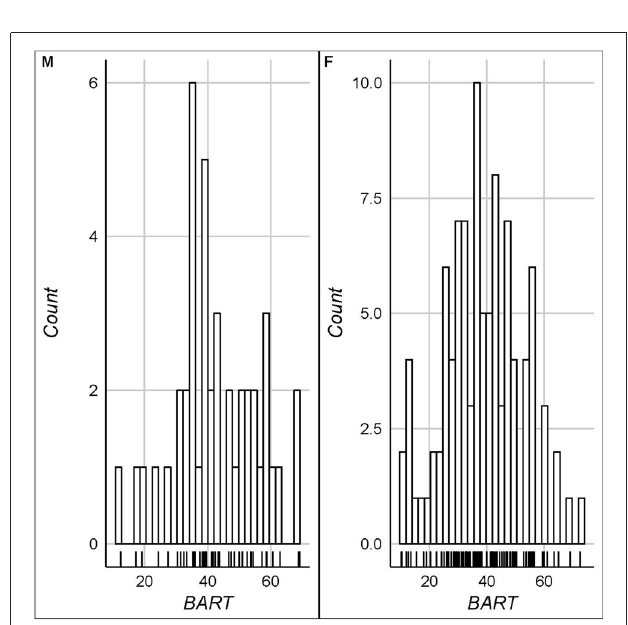
FIGURE 2 | Histograms for balloon analog risk task (BART) scores (left panel: males/right panel: females).